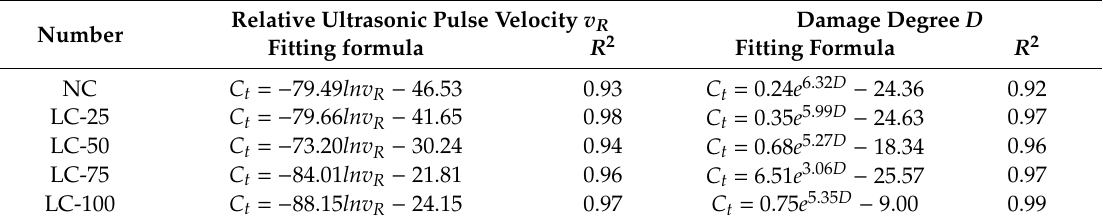
Figure 9. Relationship between ultrasonic parameters and compressive strength loss rate of concrete after exposure to high temperature: ( a ) Relationship between relative ultrasonic pulse velocity and compressive strength loss rate; ( b ) Relationship between damage degree and compressive strength loss rate. Table 5. Fitting results between ultrasonic parameter and compressive strength loss rate of concrete after exposure to high temperature.